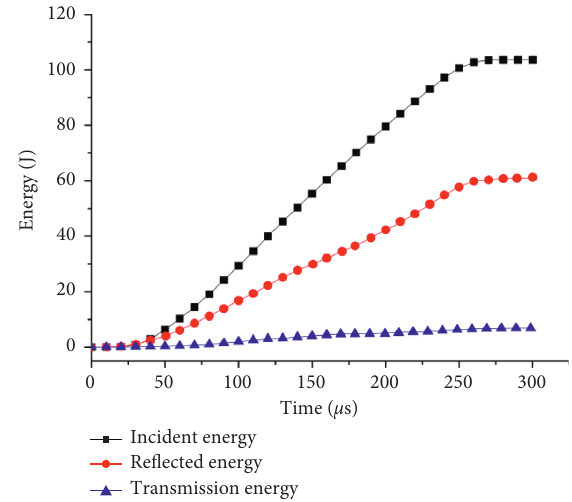
Figure 11: Energy evolution of sandstone with upper limit of cyclic load 0.6 σ b .